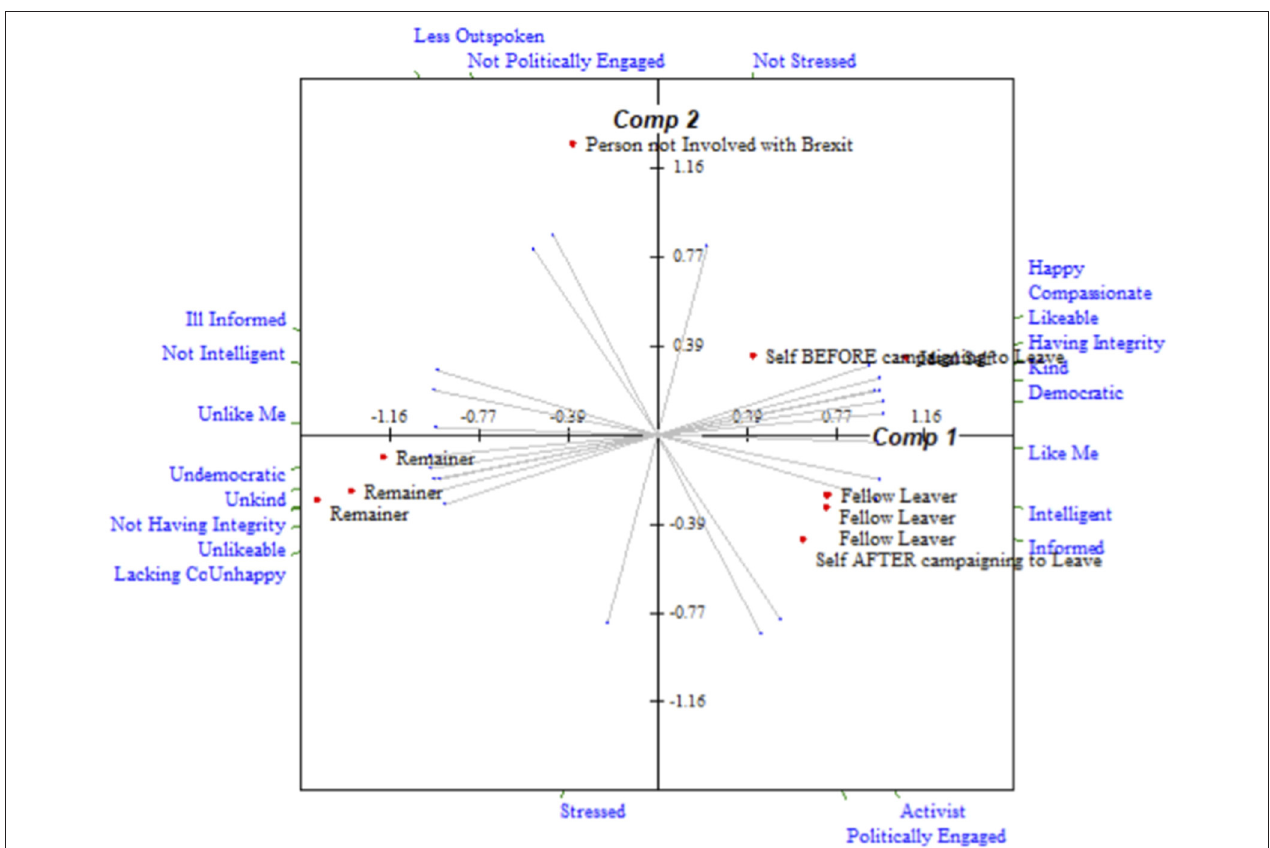
FIGURE 3 | Plot of elements in construct space for Leave average